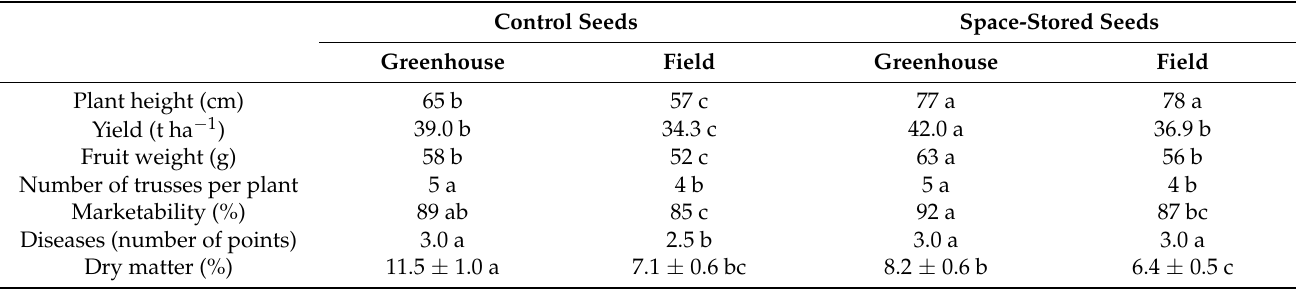
Table 2. Plant height, fruit yield, dry weight and disease occurrence of tomato grown in greenhouse and in open field, from control and spaceflight-exposed